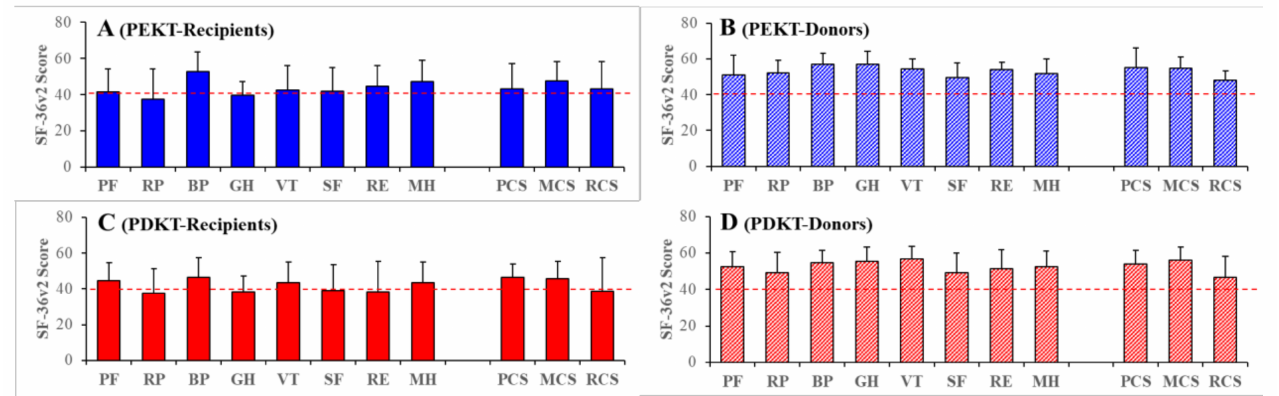
Figure 1. Short Form-36 Health Survey version 2 (SF-36v2) scores (quality of life: QOL) of recipients ( A , C ) and donors ( B , D ) in preemptive kidney transplantation (PEKT: A , B ) and post-dialysis kidney transplantation (PDKT: C , D ). Ordinates indicate the mean SD of the scores of SF-36v2. Red lines indicate the lowest SF-36v2 scores among the healthy general ± Japanese population. SF-36v2 is composed of eight subscales—“physical functioning” (PF), “role physical” (RP), “bodily pain” (BP), “general health” (GH), “vitality” (VT), “social functioning” (SF), “role emotional” (RE) and “mental